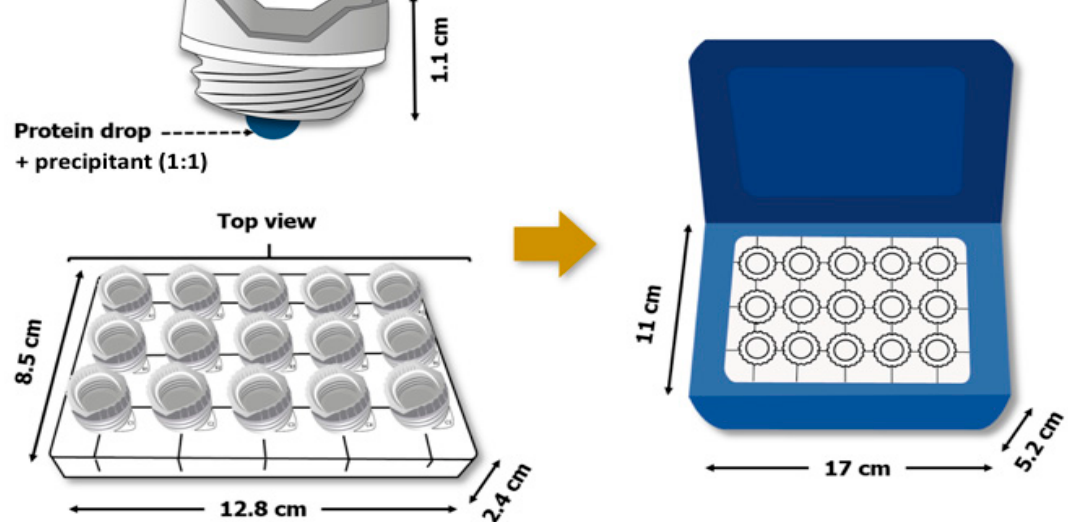
Figure 3. This shows the design of the thermal protection device, when using the Qiagen plates for protein crystallization. On the top left hand-side the cover slip with screw system contains the protein drop mixed with precipitating agent. On the right hand-side the thermal protection device with its dimensions.